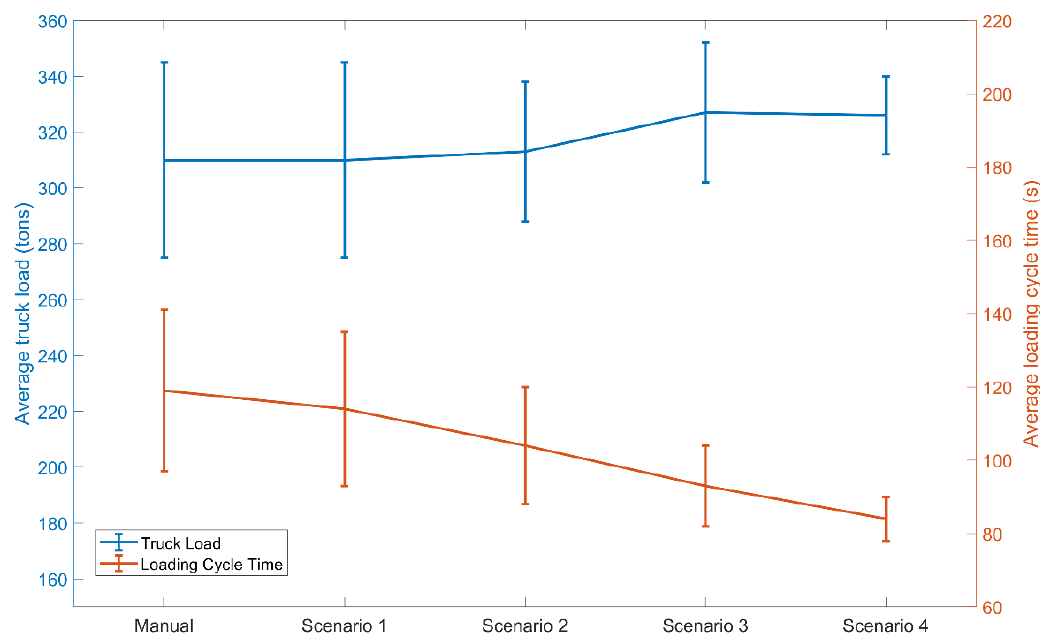
Figure 5. The average and standard deviation of total loading cycle time and a truck load.